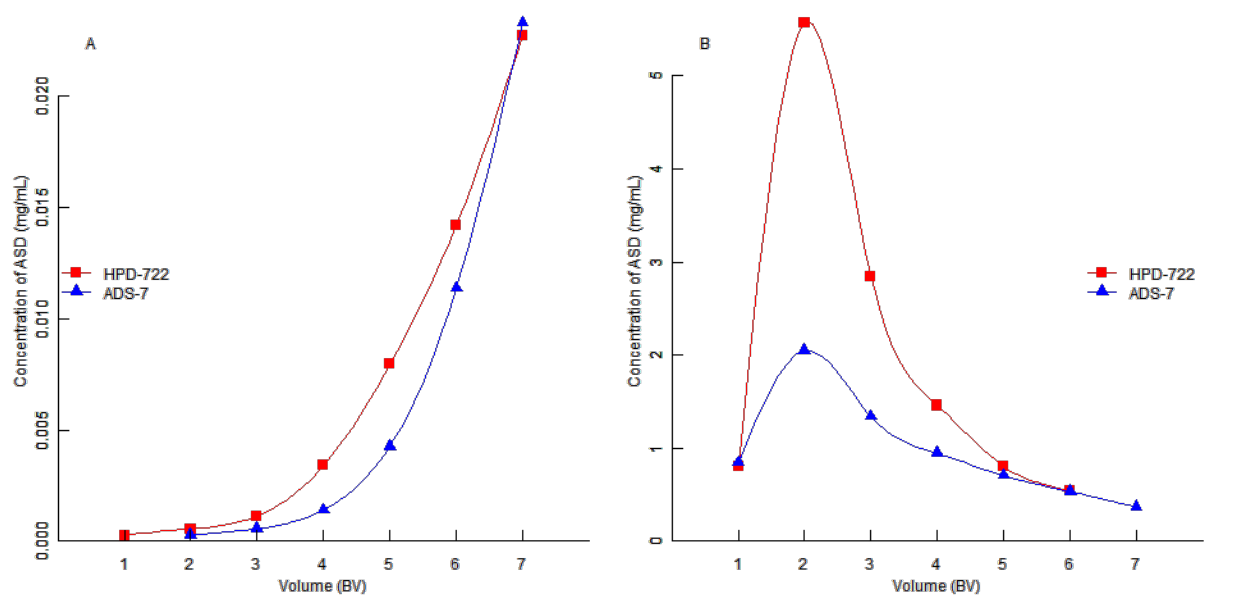
Figure 4. ( A ) The content of ASD versus volume of desorption solution on HPD-722 and ADS-7 resins at 30% ethanol solution; ( B ) The content of ASD versus volume of desorption solution on HPD-722 and ADS-7 resins at 50% ethanol